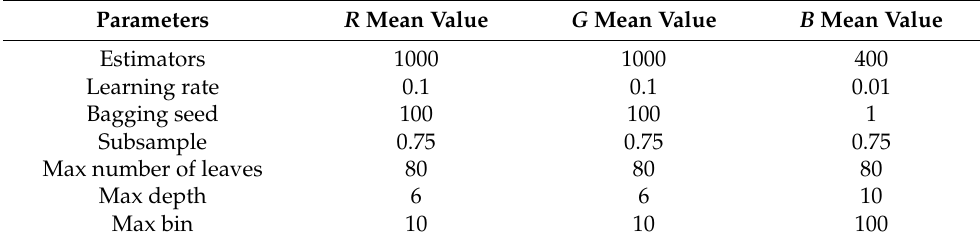
Table 1. Light gradient boosting machine (LGBM) gradient boosting regression (GBR) hyperparame- ters for RGB mean